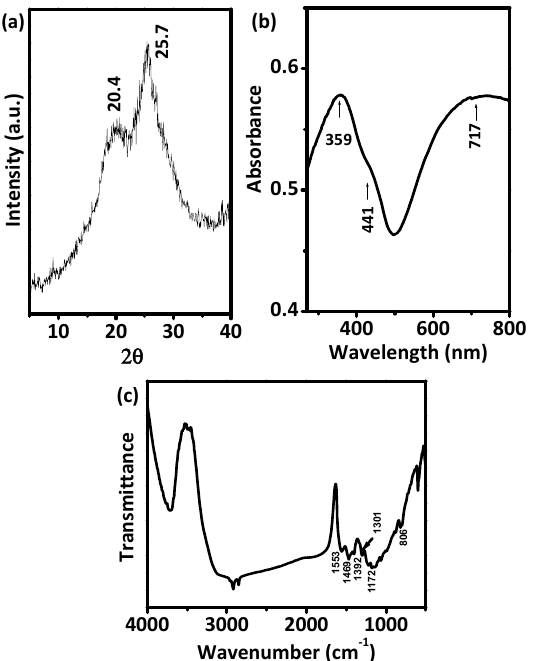
Figure 2. Characterization of PANI: ( a ) XRD pattern, ( b ) UV–visible spectrum, and ( c ) FTIR spectrum.